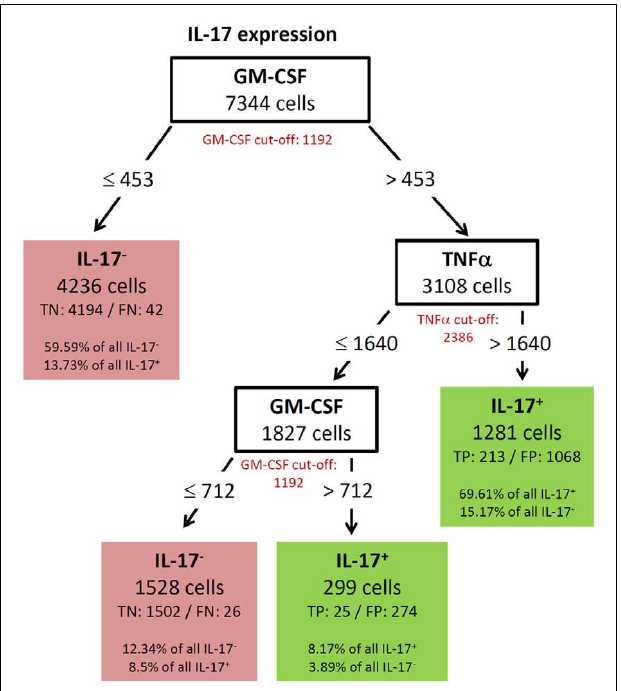
FIGURE 9 | Best decision tree for the classification of cells as positive or negative for IL-17 expression. Cells are first classified based on the MFI values of GM-CSF.The red colored GM-CSF cut-off value indicates that the split value is high below the cut-off value.The cells routed to the left node do not express GM-CSF and this value split captures 59.59% of all IL-17 negative cells and only wrongly classifies 13.73% of the IL-17 positive cells.The next split on the right is onTNF- α , but again the split value is below the cut-off value.The split values of GM-CSF andTNF- α are below the cut-off value and thus not all cells, which are routed down the path to the rightmost leaf express this two cytokines. Nevertheless this leaf correctly classifies 69.61% of the IL-17 positive cells as positive. Only 15.17% of the IL-17 negative cells are wrongly classified in this leaf. Also the last split value again on GM-CSF is below the cut-off value.